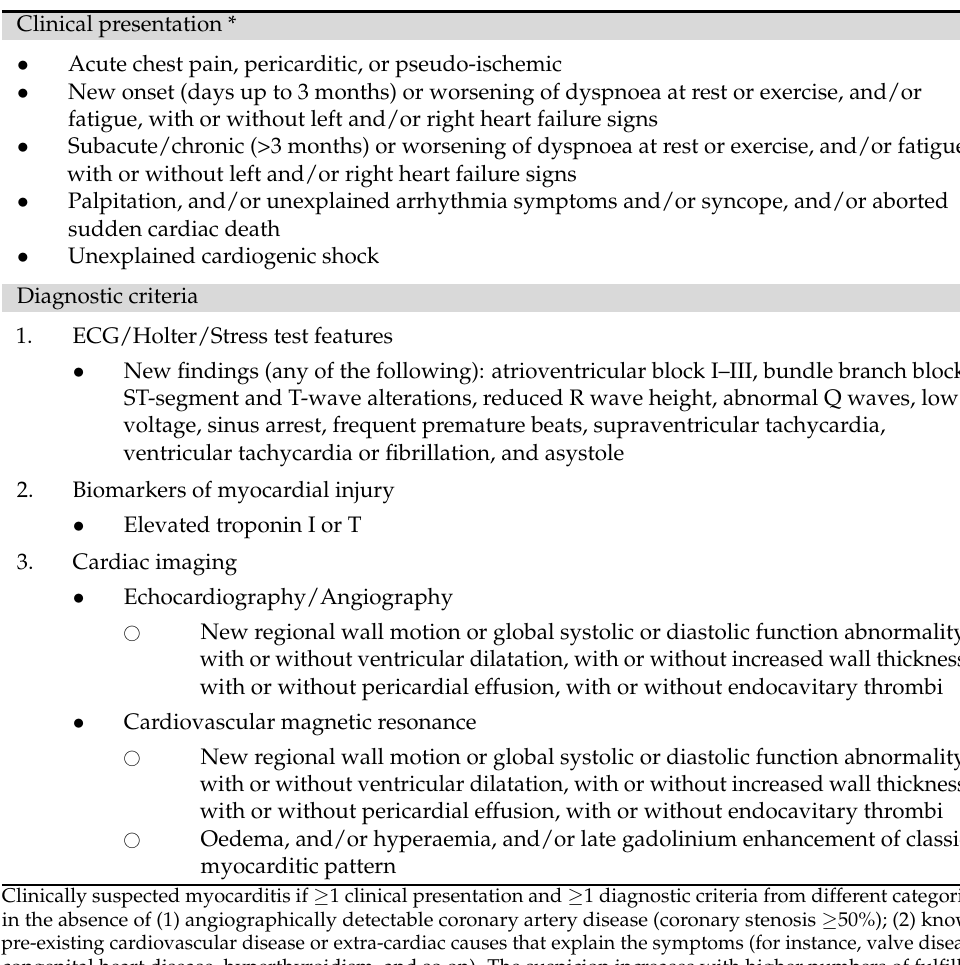
Table 1. Diagnostic criteria for clinically suspected